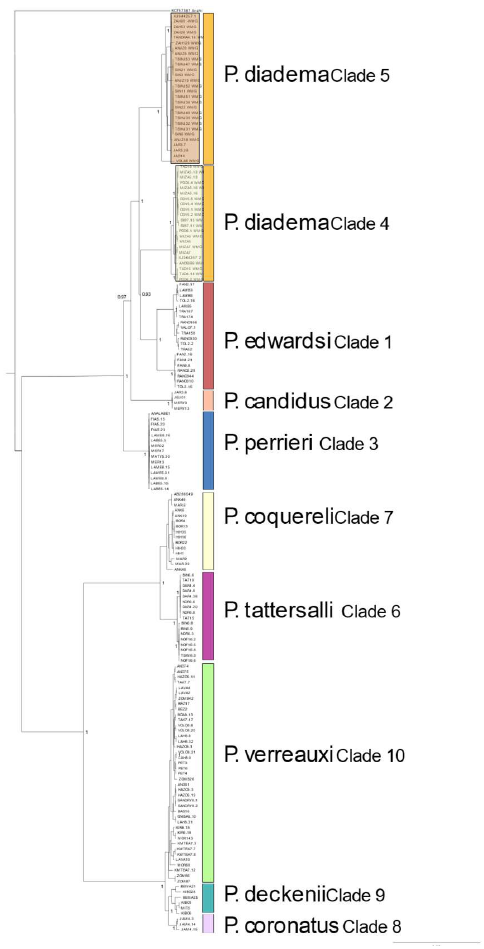
Figure 3. Complete mitochondrial genome phylogenetic tree showing mitochondrial introgression between P. edwardsi (clade 1) and P. diadema clade 4. All other species were recovered as reciprocally monophyletic. Posterior probabilities shown at nodes.